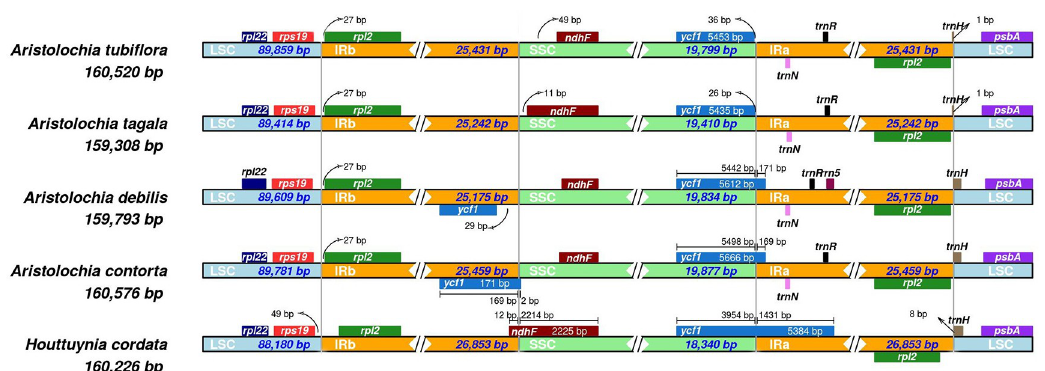
Fig 6. Analysis of the boundaries of LSC/SSC/IR and adjacent genes among five Piperales cp genomes. Sequences of the LSC/ IRB/SSC/IRA boundaries and adjacent genes in H . cordata and four closely related cp genomes, including A . contorta , A . debilis , A . tagala , and A . tubiflora , were downloaded from GenBank and